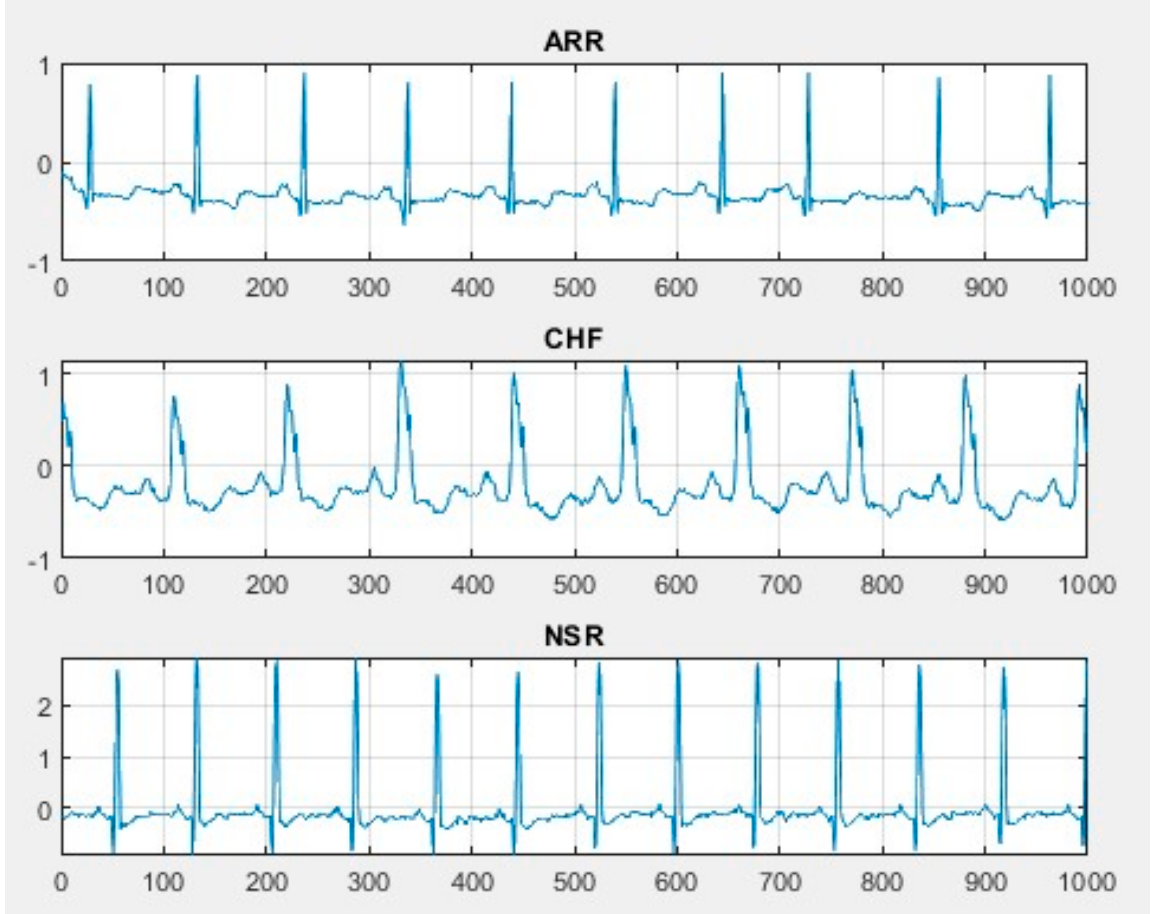
Figure 11. An illustrative example of the three classes of ECG time series signals.